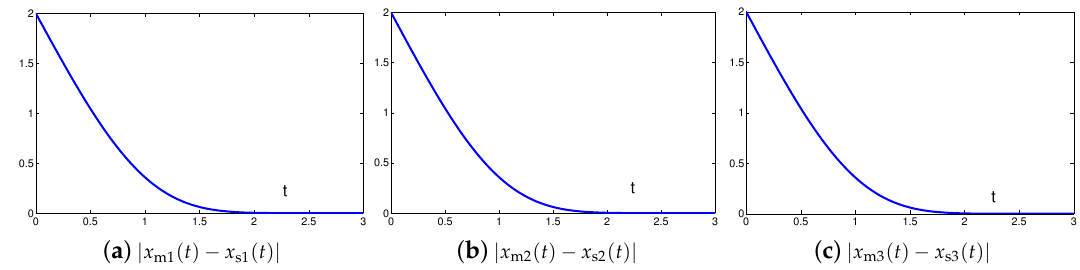
Figure 4. Absolute errors between two identical Lu chaotic systems (24) and (25) equipped with controller (6) via the proposed SEZN approach.